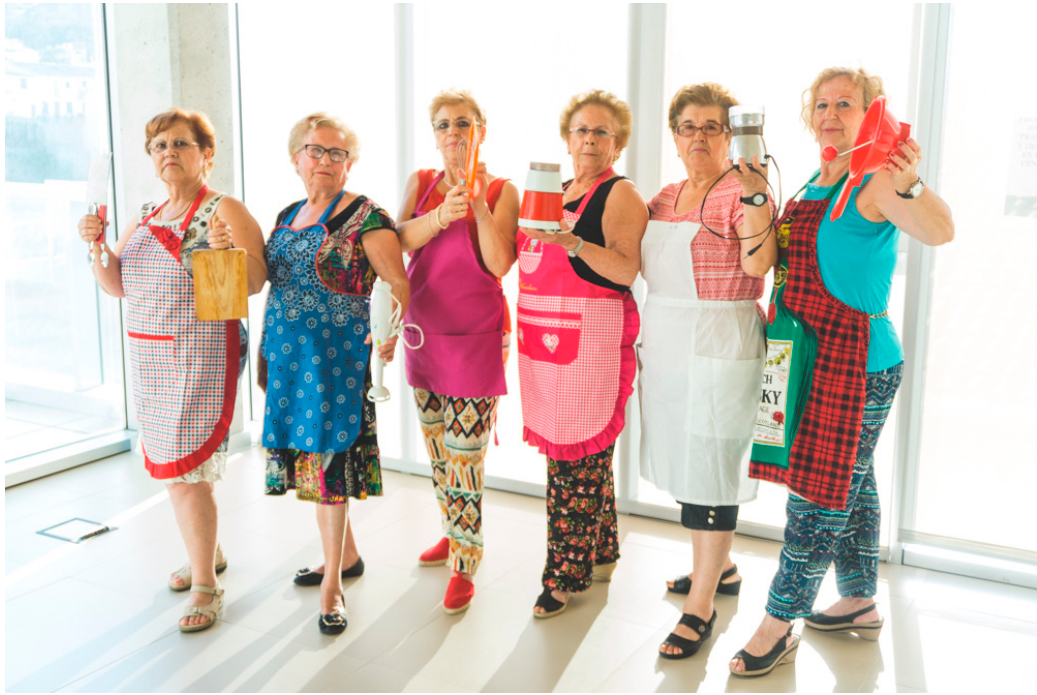
Figure 6. Las Atrevidas: The Risk Takers , Artist Residency at Centro Negra AADK, Blanca, Murcia, Spain, 2015. Group portrait. Video: duration 10 min.